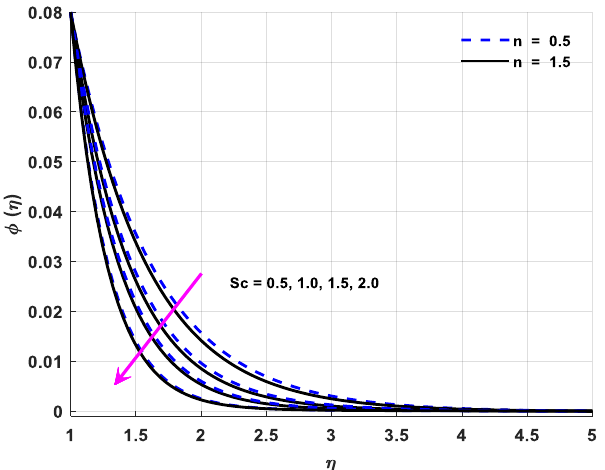
Figure 11. Variations in species concentration profiles owing to changes in Sc .